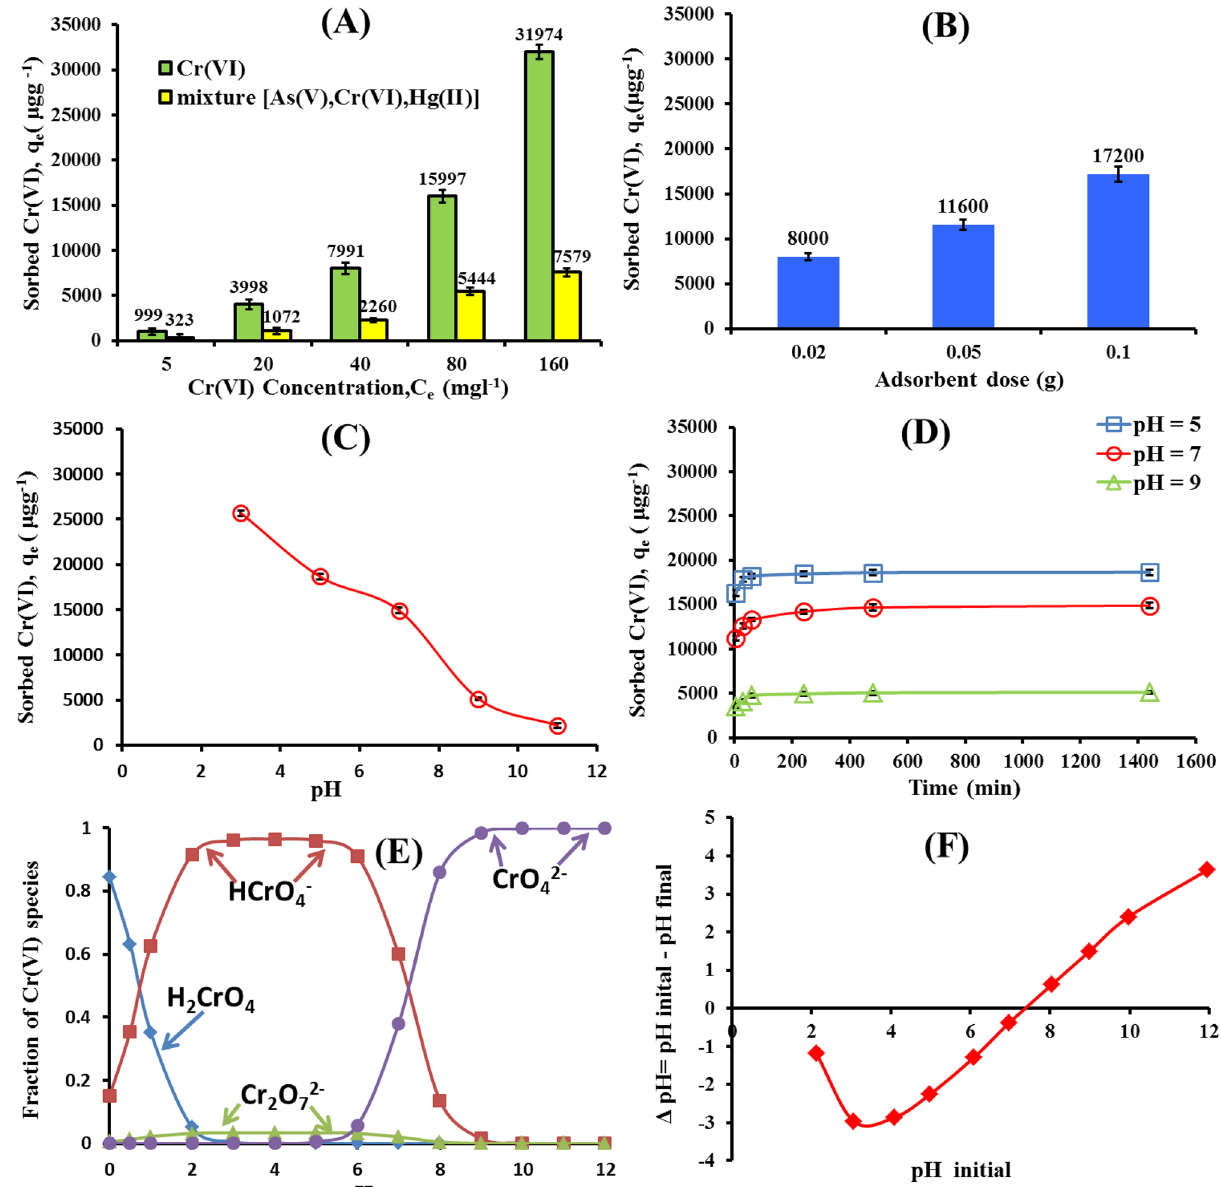
Figure 3. Effect of initial Cr(VI) concentration and competing ions ( A ), adsorbent dose ( B ) solution pH ( C ) and Contact Time ( D ) on the Cr(VI) adsorption by nWTRs. Cr(VI) species ( E ), and zero point charage of nWTRs ( F